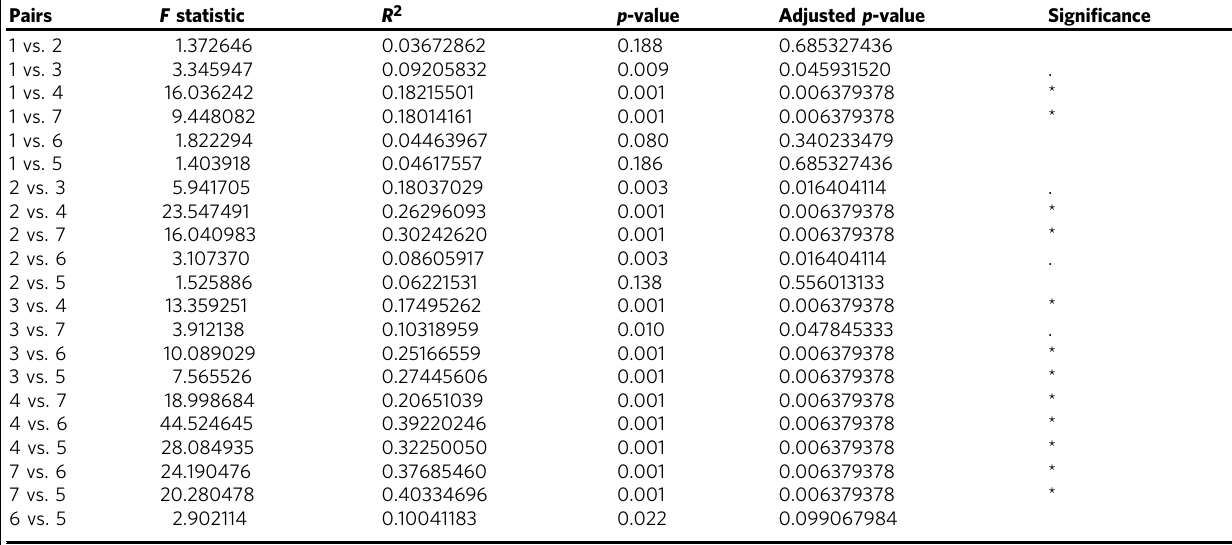
Table 2 Heterogeneity in functional pro fi ling of modules in the sponge core – microbiome network Pairs F statistic R 2